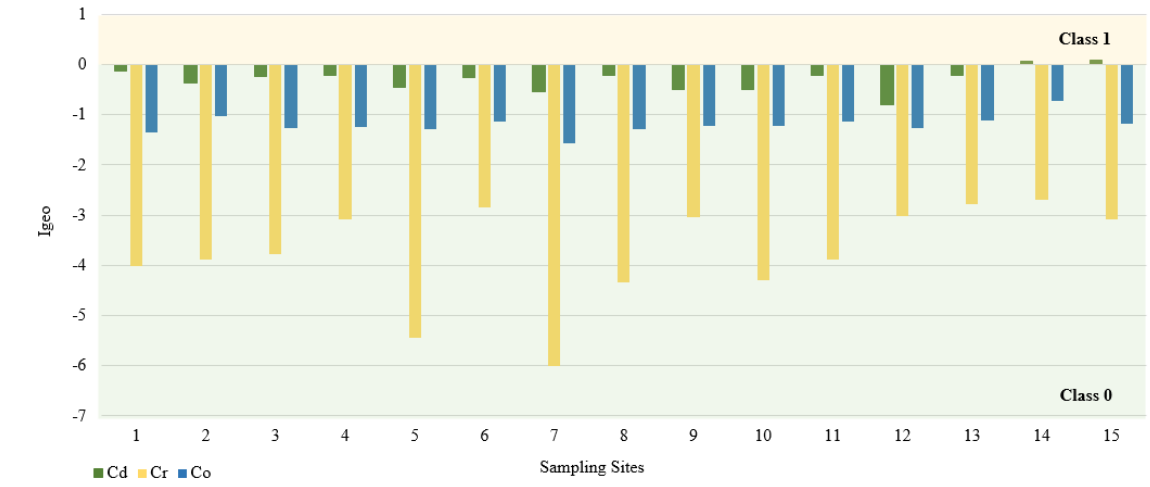
Figure 2. Igeo values for PTEs at different sampling sites.